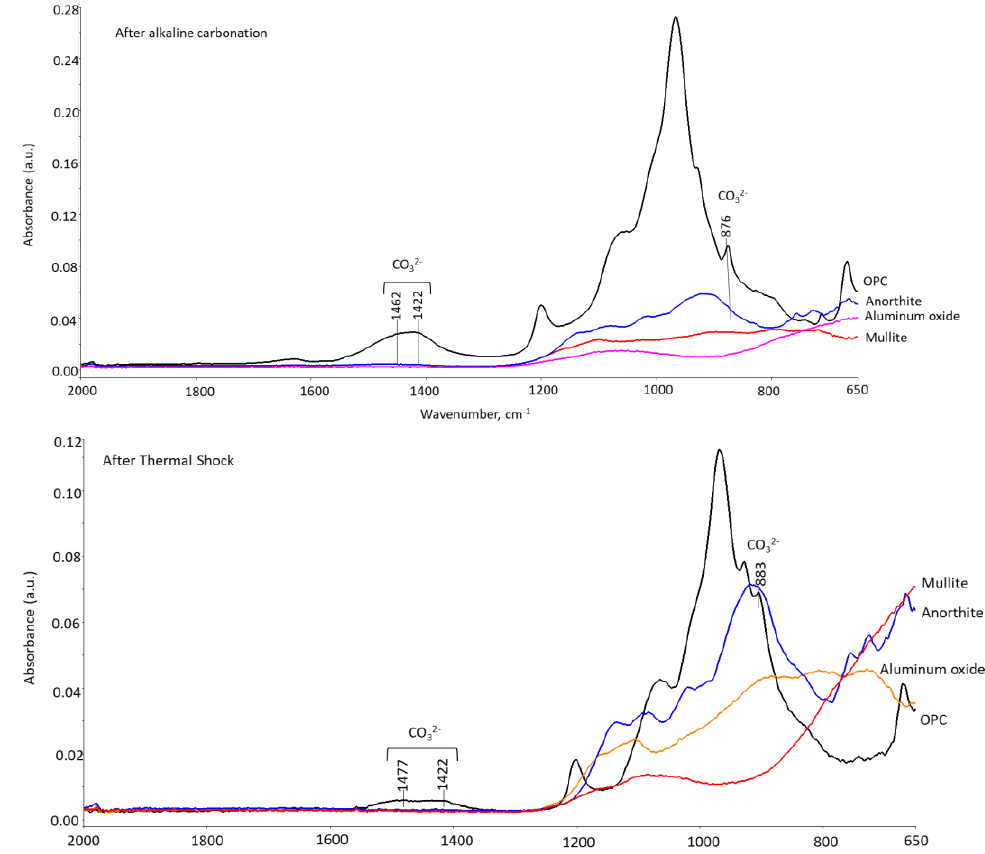
Figure 25. FTIR spectra of tested materials after exposure to alkaline carbonate (250 °C, 40 days) and 3 cycles of thermal shock (one cycle: 600 °C heat overnight → cold water quenching for 10 min).